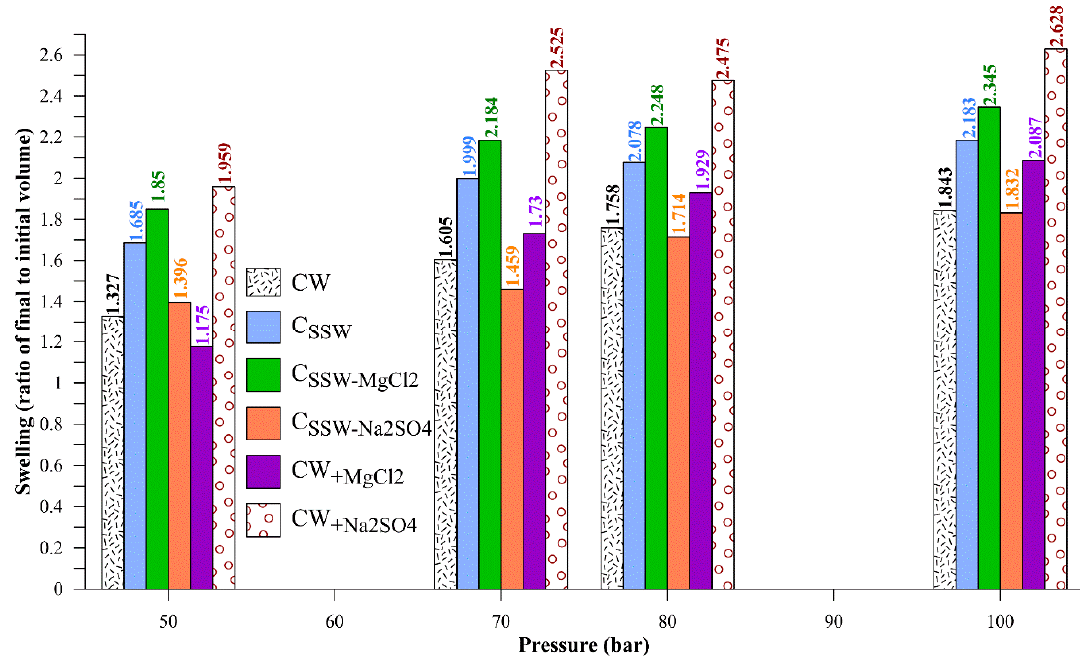
Figure 4. Swelling (ratio of final to initial volume) of the n-decane pendant for different carbonated brines for the pressure range of 50-100 bar at 45 °C.